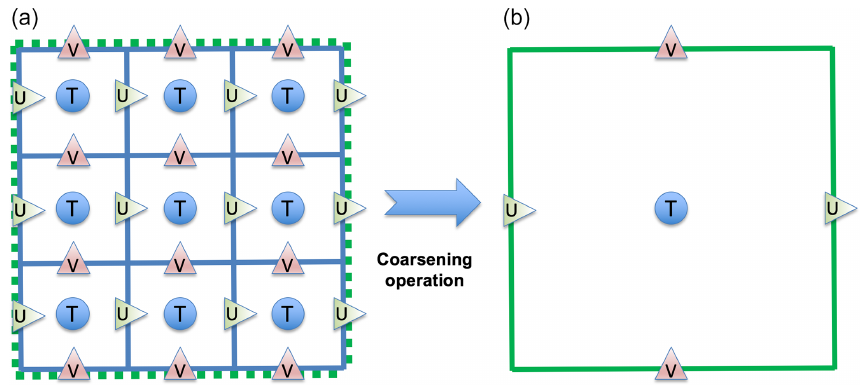
Figure 1. Schematic diagram illustrating the definition of the coarsened grid for a coarsening factor of 3 (ocean high-resolution grid is in panel a ; coarsened grid for biogeochemical model is in panel b ) and localization of tracer ( T , blue dots), zonal velocity ( U , green triangles) and meridional velocity ( V , red triangles) points in both grids. Grid sections that are common to both grids are coloured in green.